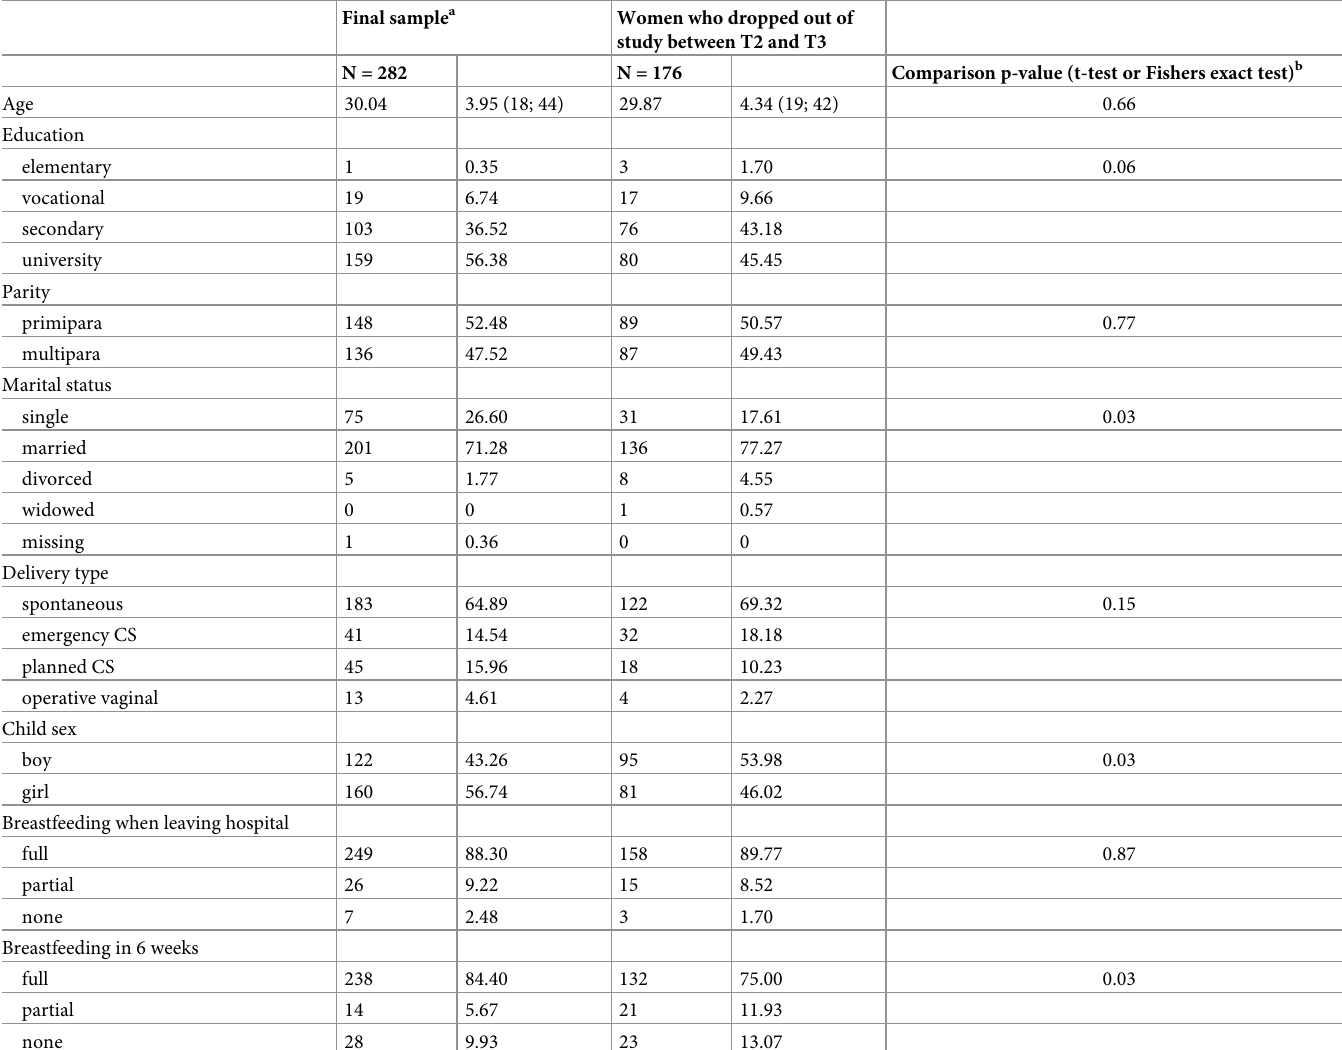
Table 1. Characteristics of the